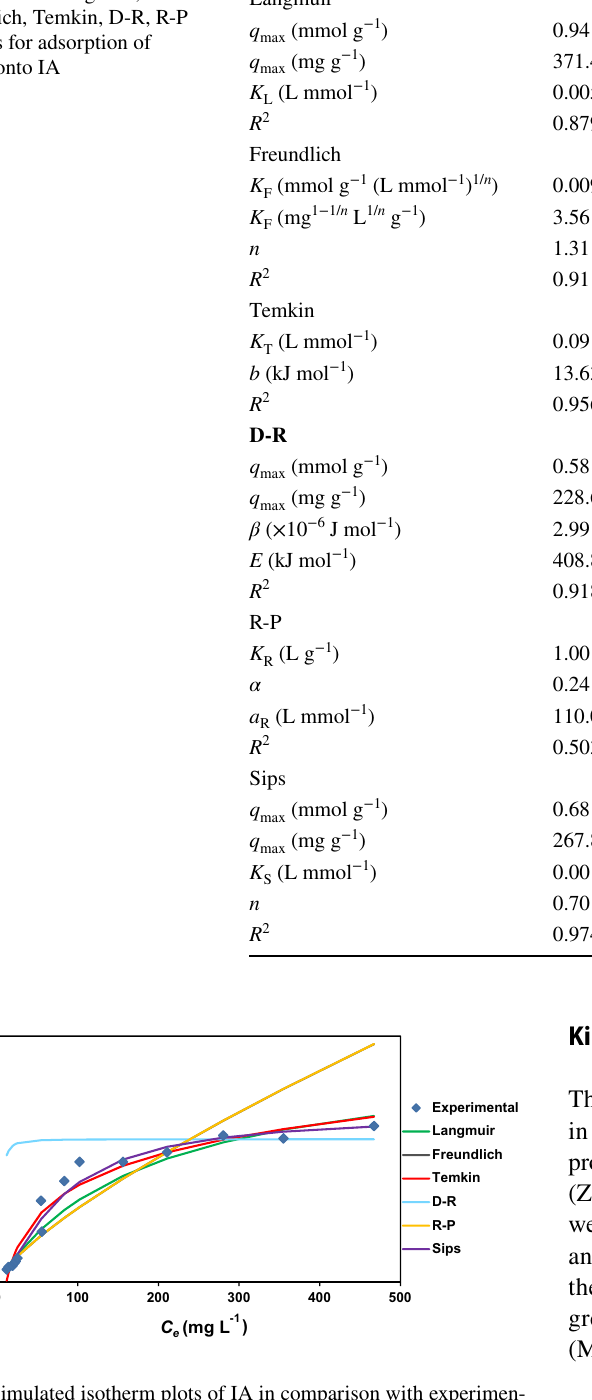
Fig. 4 Simulated isotherm plots of IA in comparison with experimen- tal isotherm curve for adsorption of